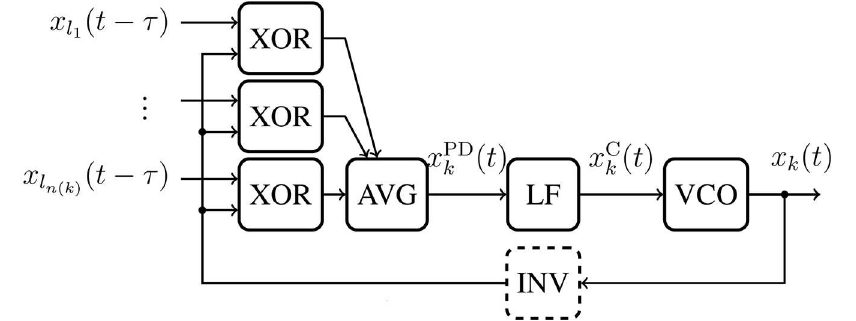
Fig 3. Signal flow of a DPLL with multiple delayed input signals. Each input signal x l undergoesthe XOR operationwith the feedbacksignalindividually.The resultingsignalsare